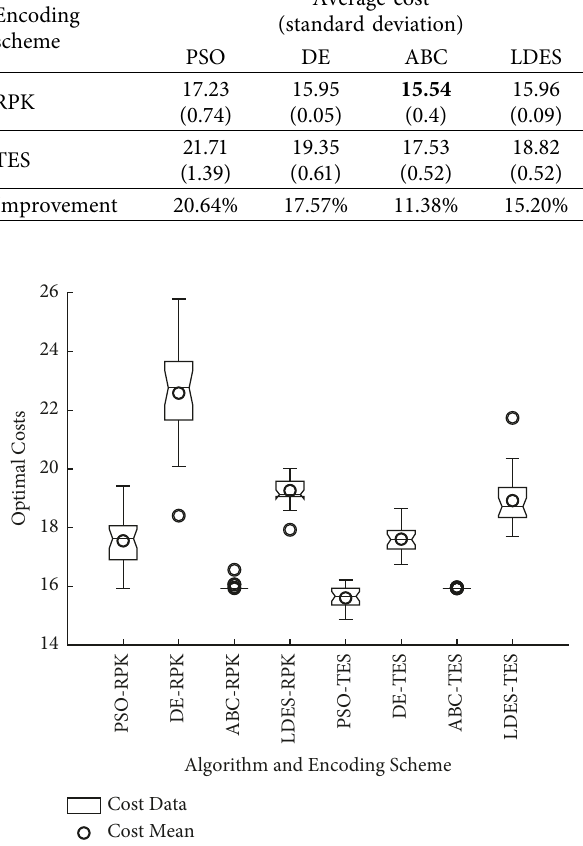
Figure 6: Statistics of the optimal costs in 30 runs of PSO, DE, ABC, and LDES using RPK and TES encoding